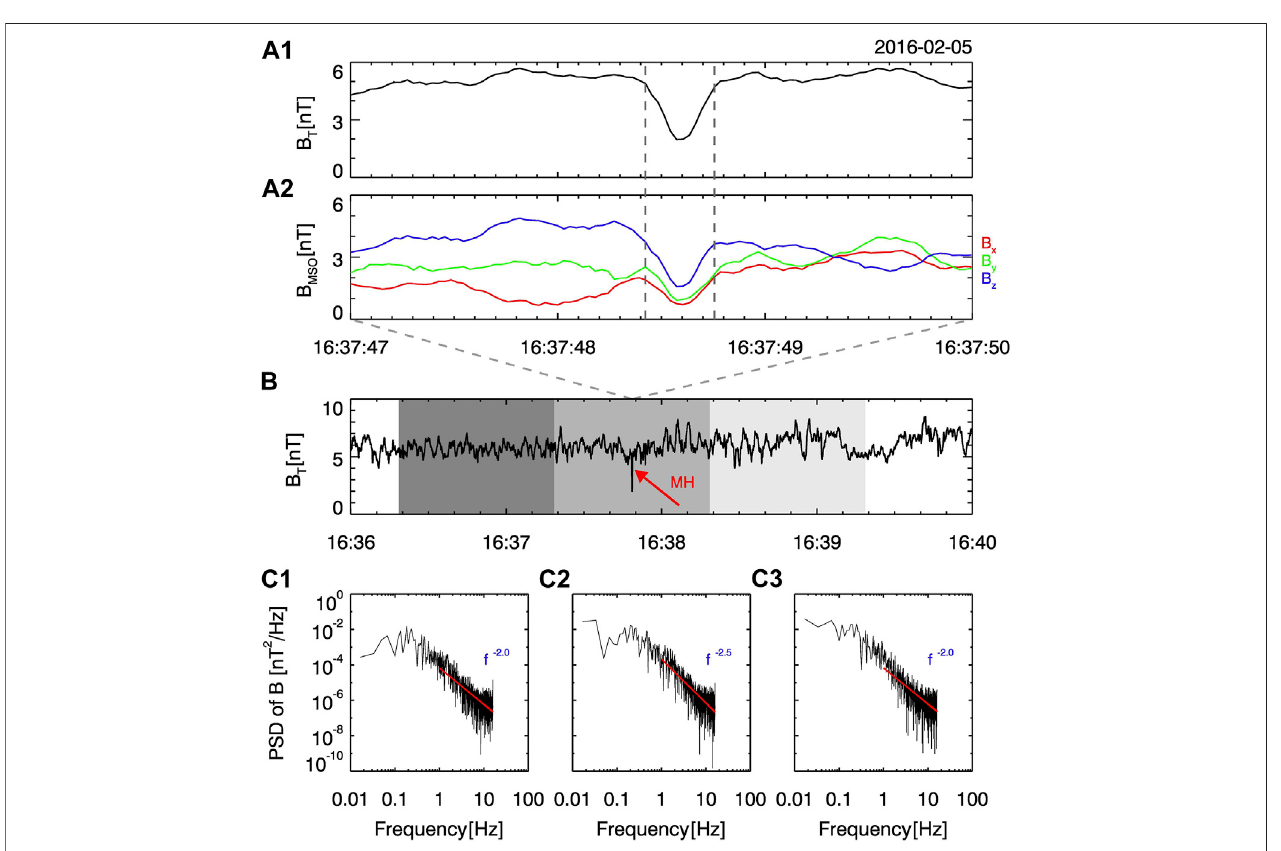
FIGURE 1 | Small-scale magnetic hole observed in the Martian magnetosheath by MAVEN on 05 February 2016. (A1) Magnetic fi eld magnitude. (A2) Three components of the magnetic fi eld (red, cyan, and blue are the x, y, and z components of the magnetic fi eld, respectively) in MSO coordinates. The time interval of the small-scale magnetic hole is marked by two vertical gray dashed lines in (A1) and (A2) . (B) Time series of the total magnetic fi eld. The dark gray region is the 1-min window before the MH, the gray region is the 1-minute window containing the MH, and the light gray region is the 1-min window after the MH. (C1-C3) PSDs computed by the 1-min window before, containing, and after the MH,